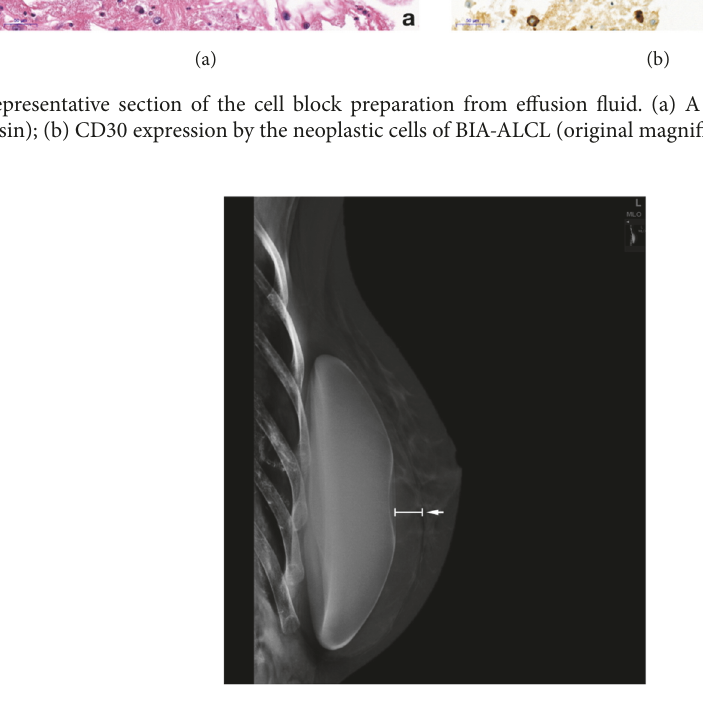
Figure 3: Mediolateral oblique view of the left breast shows a rim of density surrounding the silicone implant (white